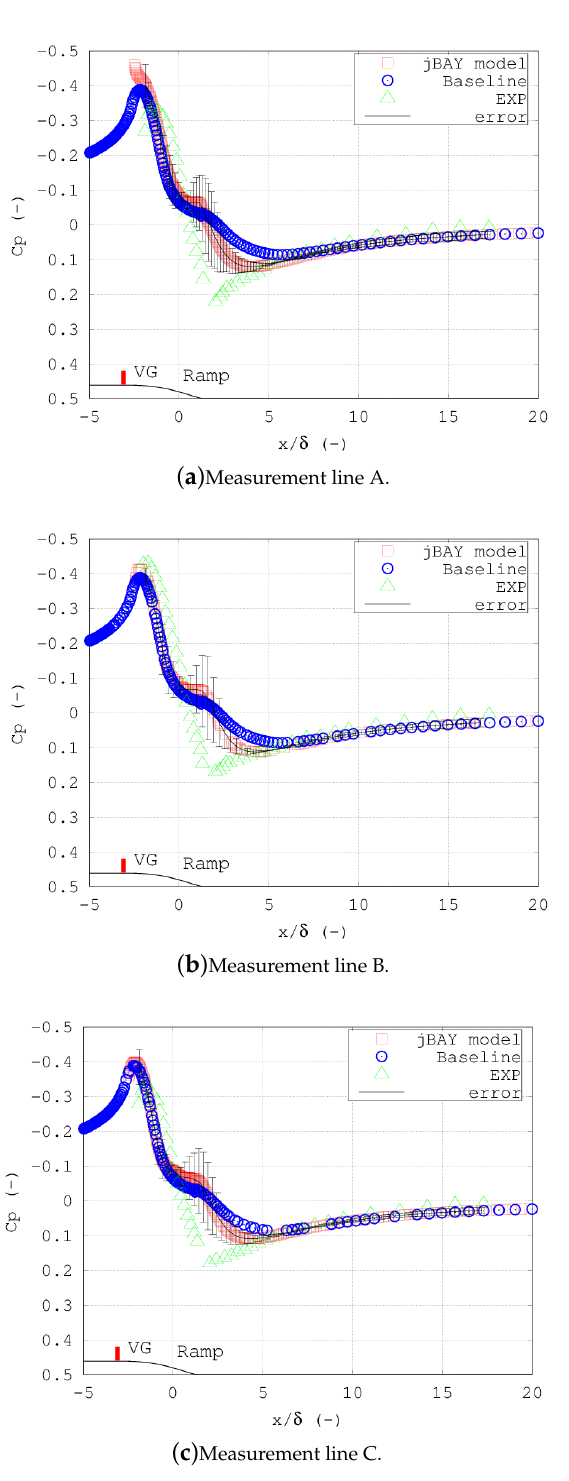
Figure 10. Streamwise pressure distribution c p along the measurement lines A, B and C on the flat plate floor. Plots corresponding to the H 2 = 0.2 δ vane-type VG